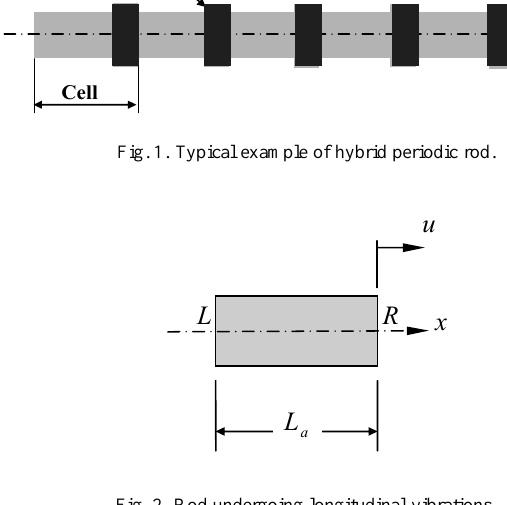
Fig. 2. Rod undergoing longitudinal